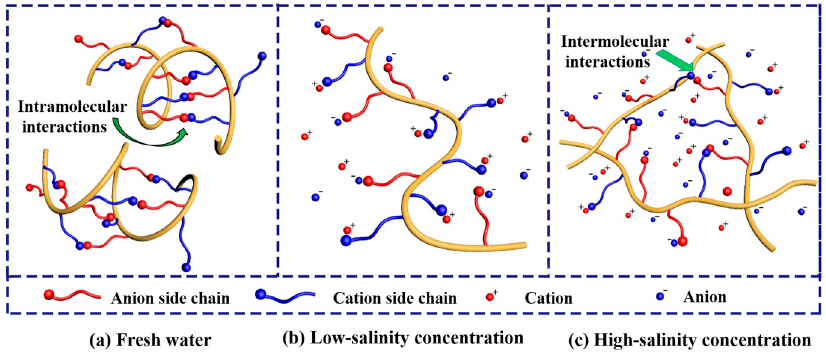
Figure 7. Thickening mechanism of PASD chains in ( a ) fresh water; ( b ) the low-salinity solution; and ( c ) the high-salinity solution.